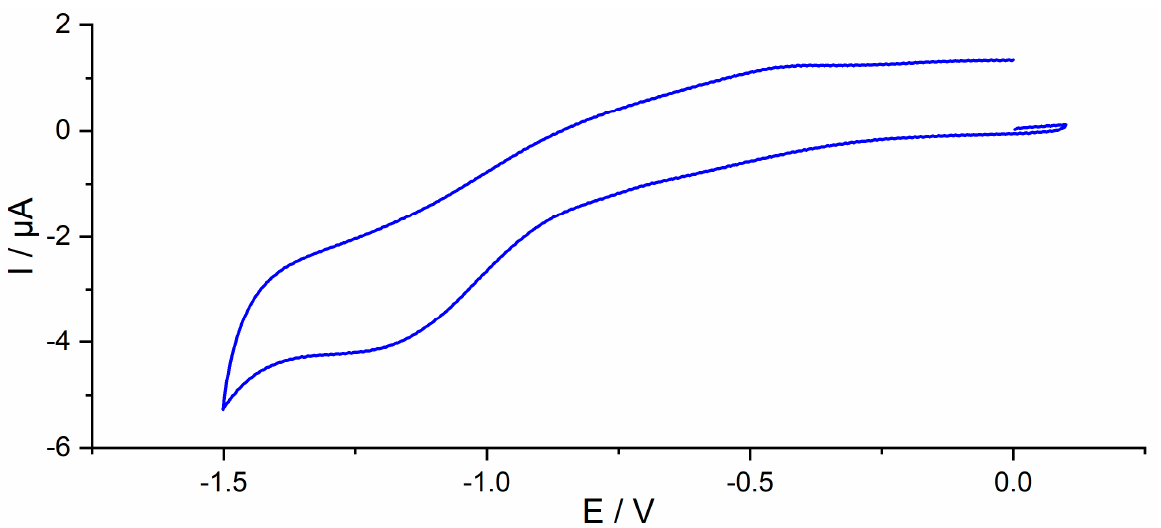
Figure 8. Cyclic voltammogram showing the reduction phase at a platinum electrode of CNF–PSA–